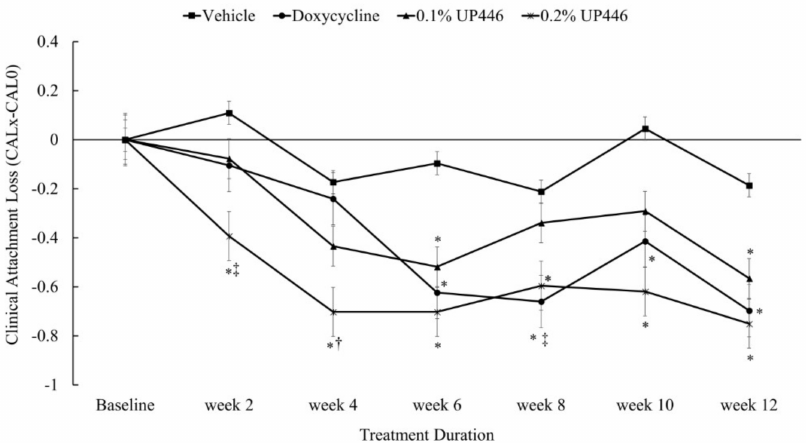
Figure 5. Changes in mean clinical attachment level in beagle dogs with ligature-induced periodontitis. Values are represented as di ff erences between before and after treatment. *; denote significance at p < 0.05 when compared with placebo and treated groups at the same week. † ; denote significance at p < 0.05 when compared with doxycycline and UP446 groups at the same